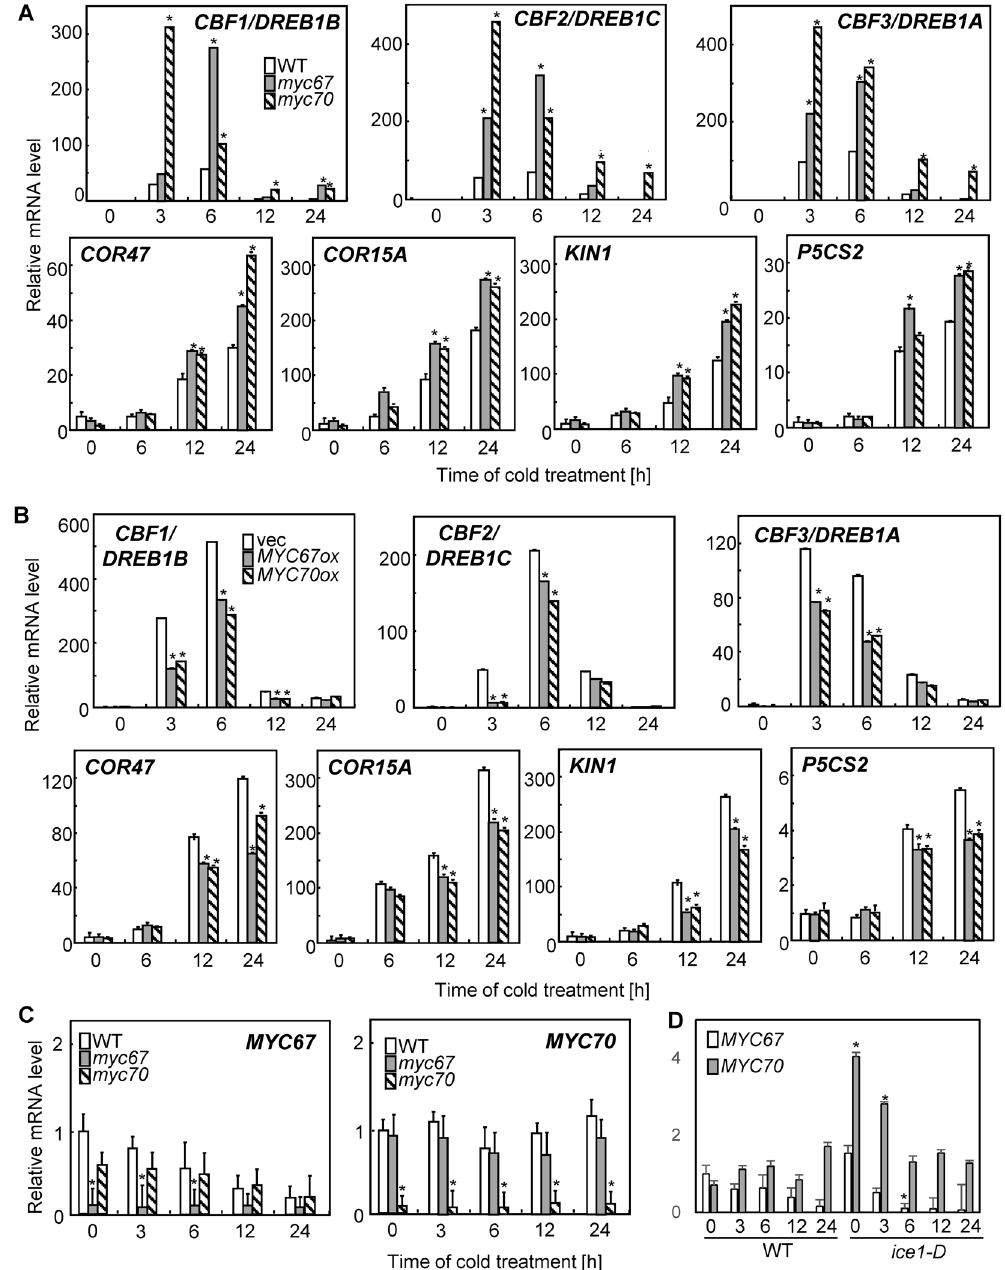
Figure 4. MYC67 and MYC70 negatively regulate the expression of cold-responsive genes. ( A ) The relative mRNA transcript levels of CBF / DREB1 genes, COR47 , COR15A , KIN1 , and P5CS2 in wild-type, myc67 and myc70 seedlings were determined by quantitative RT-PCR analysis. Ten-day-old seedlings grown at 23 °C were incubated at 4 °C for the indicated amounts of time. The data indicate the means and SD (n = 3). ( B ) The relative mRNA transcript levels in wild-type, MYC67 -, and MYC70 -overexpressing seedlings were determined by quantitative RT-PCR. The data indicate the means and SD (n = 3). ( C ) The expression levels of MYC67 and MYC70 after cold treatment were measured by quantitative RT-PCR analysis. ( D ) Expression level of MYC67 and MYC70 after cold treatment in wild type and the ice1 - D mutant. Asterisks indicates a significant difference from wild-type or plants with a vector at each point (p < 0.05) as determined by Student’s t-